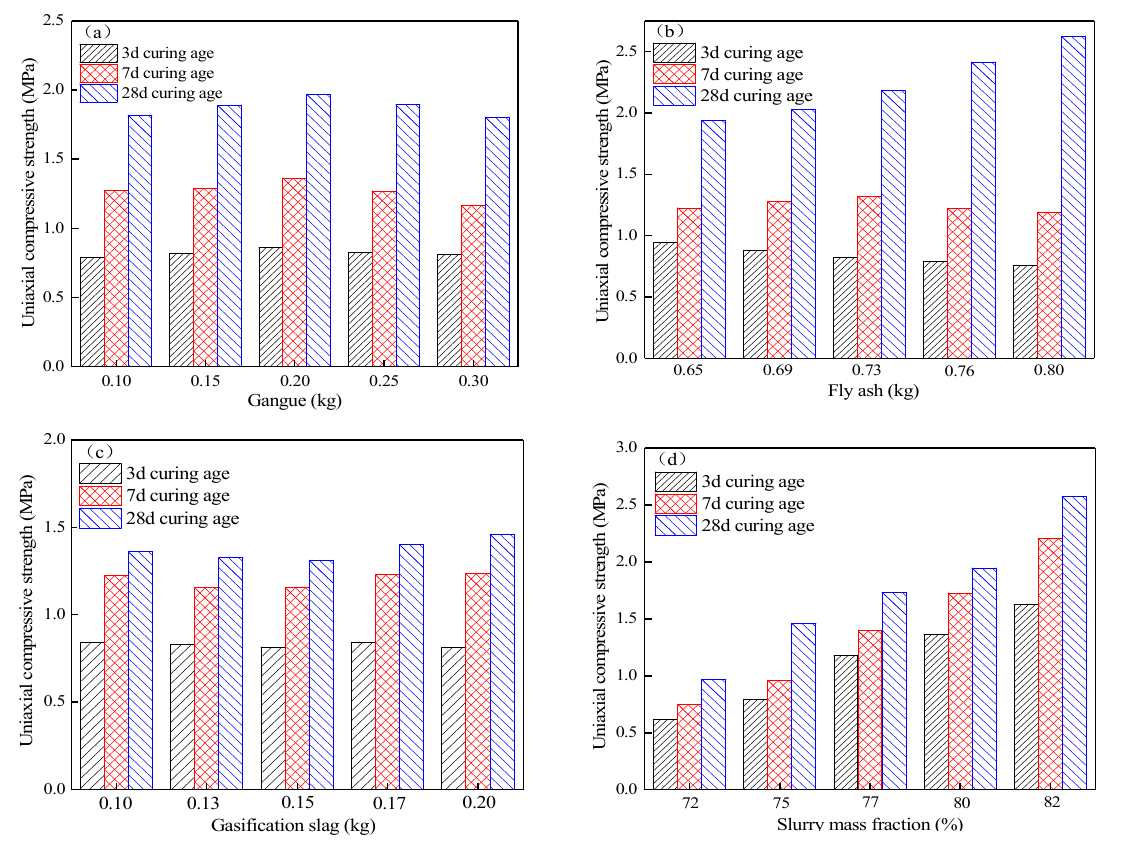
Figure 7. Effect of single factors on the strength of the filling body: ( a ) gangue; ( b ) fly ash; ( c ) gasi-